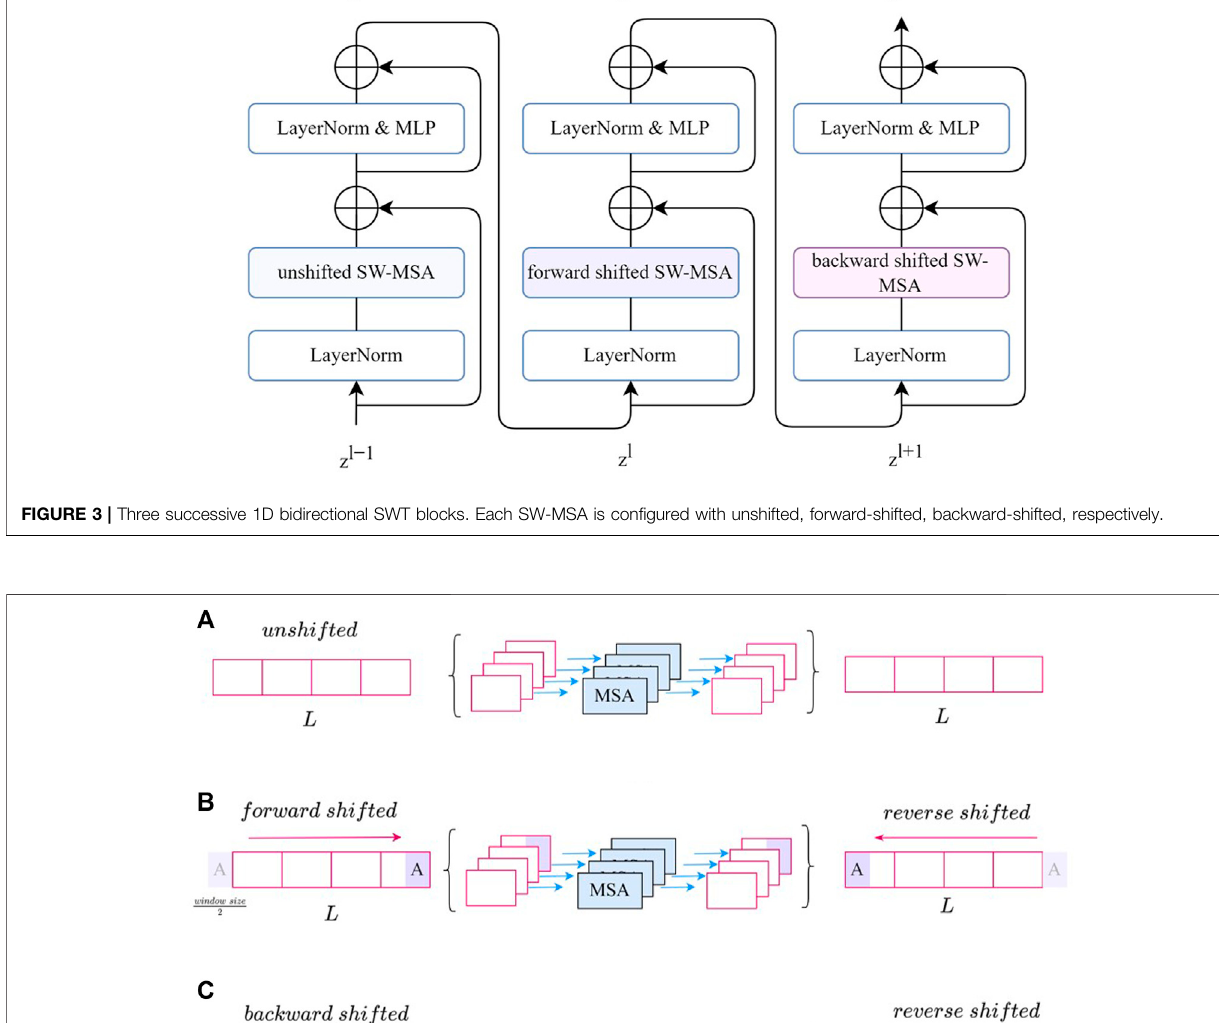
Frontiers in Physiology |